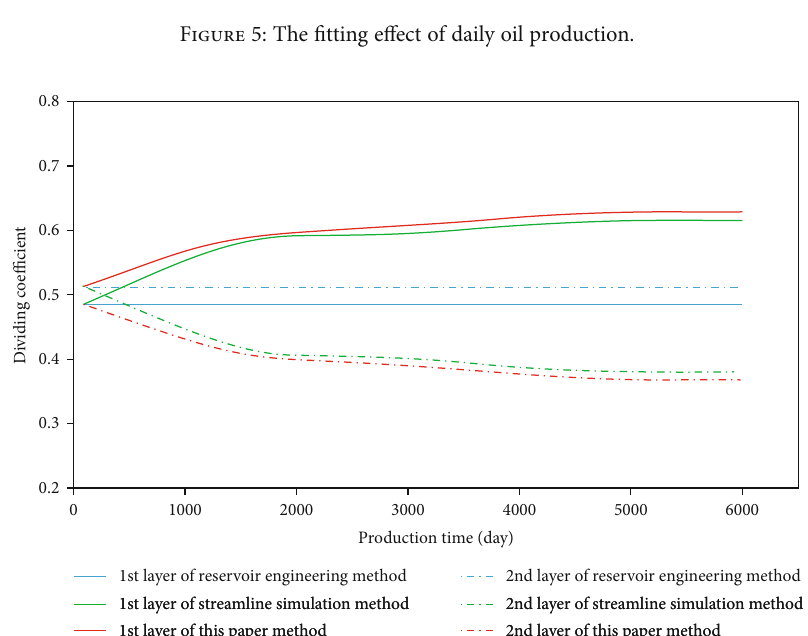
Figure 6: Vertical dividing coe ffi cient of